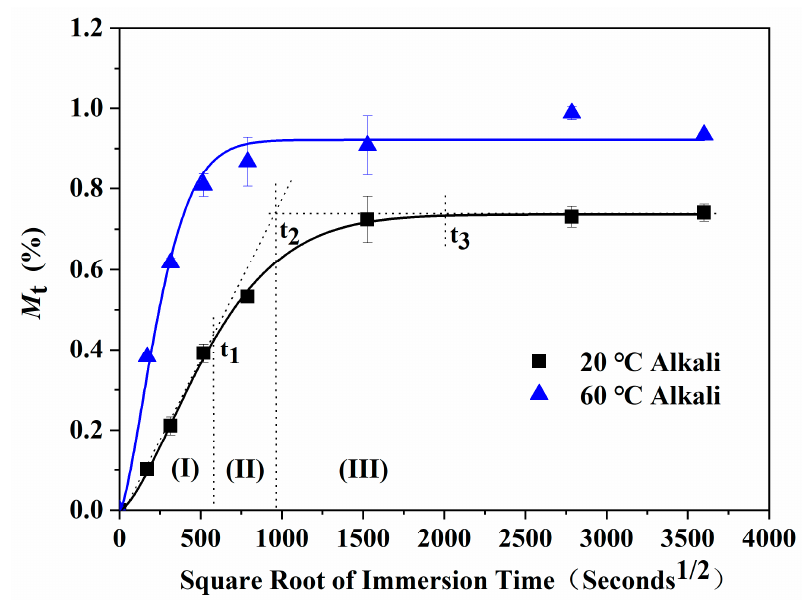
Figure 4. Water uptake curves of the epoxy resin specimens immersed in the alkali solution at different temperatures. Solid lines represent the fitting curves using Fick’s model.